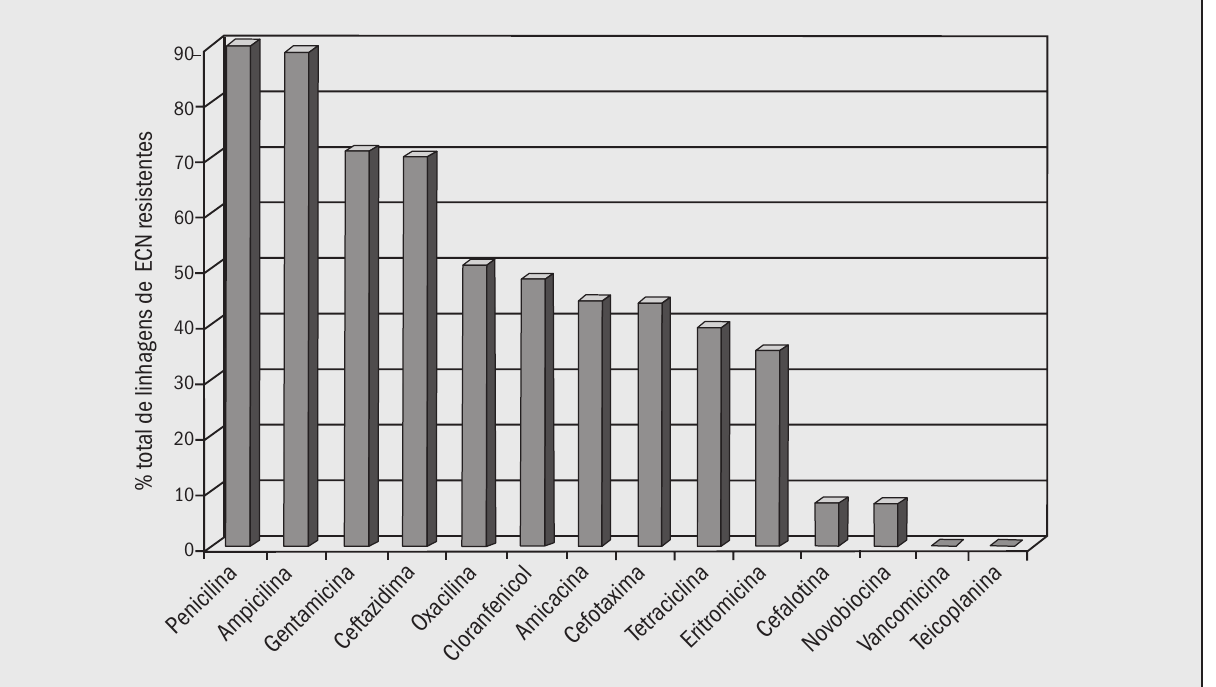
Figura 6 – Resistência às drogas apresentada pelas linhagens de